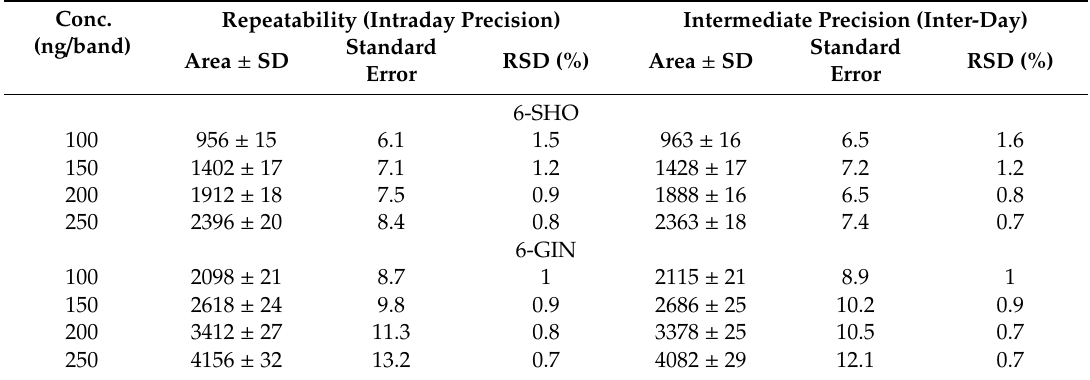
Table 3. Precision data of 6-SHO and 6-GIN for the green RP-HPTLC method (mean ± SD; n = 6). Conc.